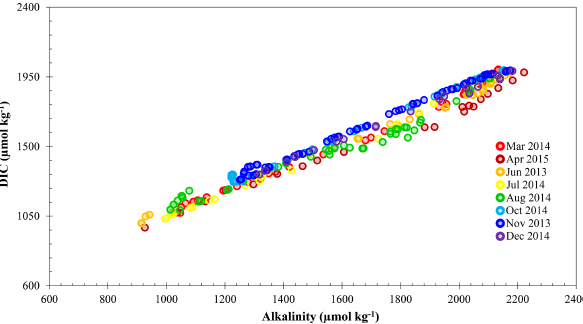
Figure 8. DIC versus alkalinity measured along the axis of the Delaware